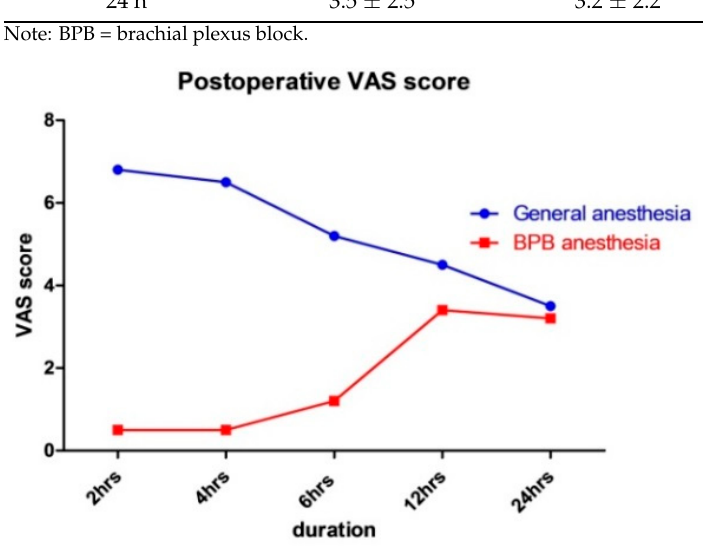
Figure 1. VAS scores over time after DRF surgery in the GA and BPB groups. Table 2. Visual analog scale (VAS) scores in both groups at different times after surgery.